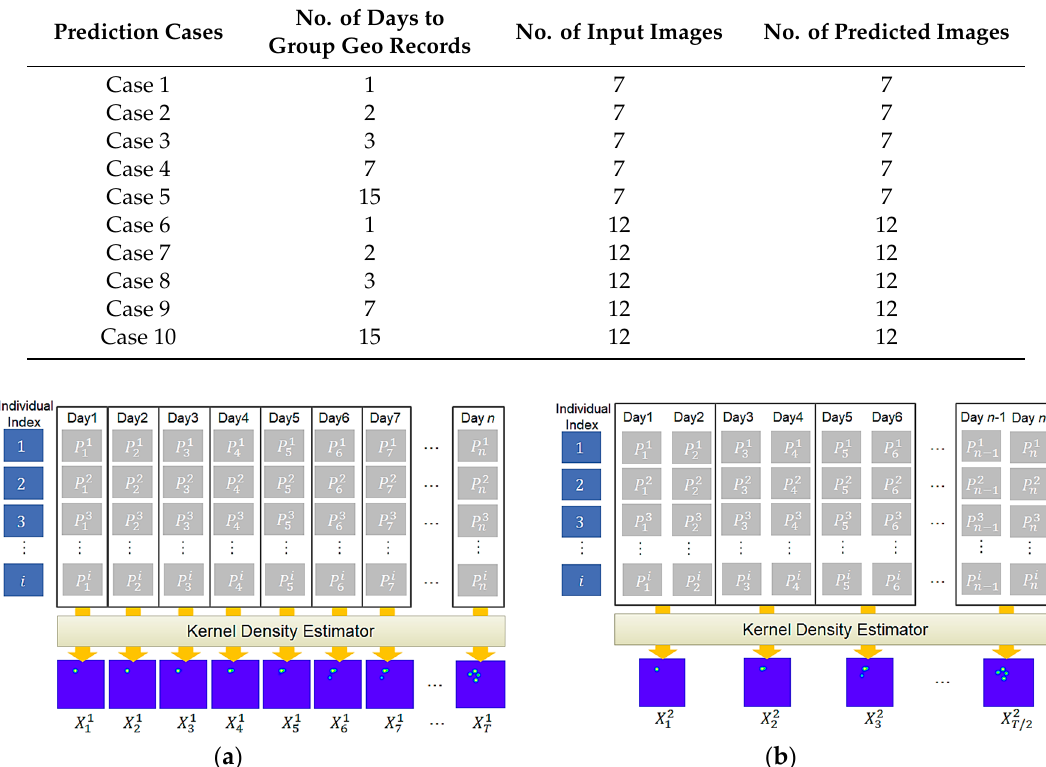
Table 2. Experiment outline.